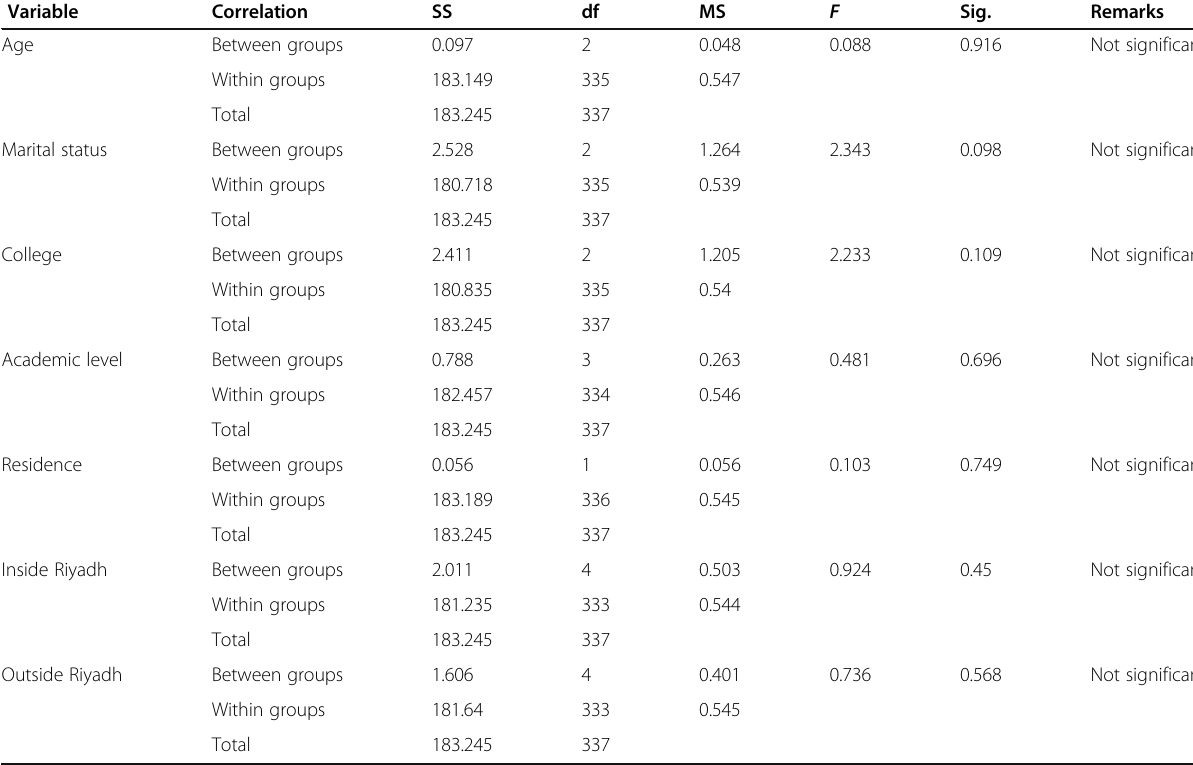
Table 3 Mean difference of MWB based on sociodemographic variables done by ANOVA